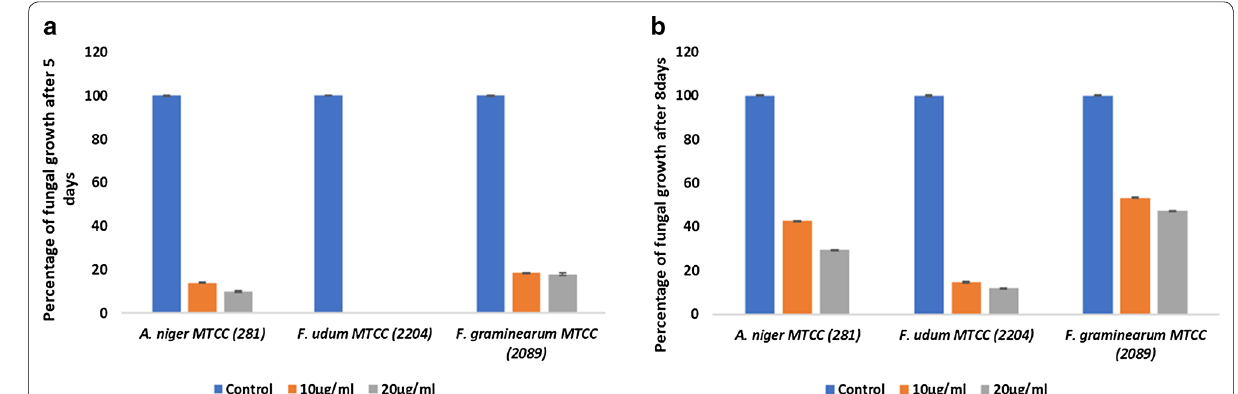
Fig. 6 "> a Percentage growth of fungi after 5 days of incubation, treated with 10 µg/ml and 10 µg/ml of CANCs. b Percentage Growth of fungi after 8 days of incubation, treated with 10 µg/ml and 10 µg/ml of